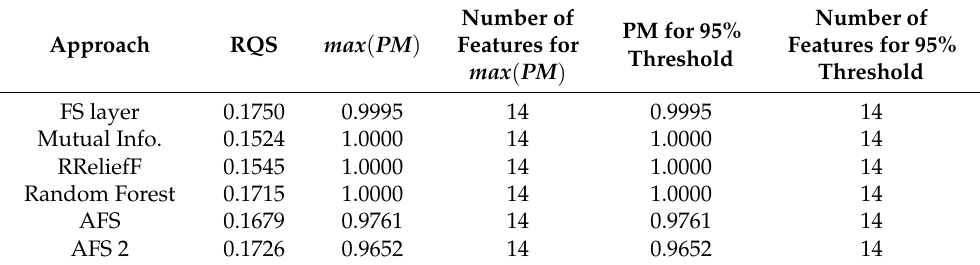
Table 14. Task performance and ranking quality for C-MAPSS FD004 dataset.